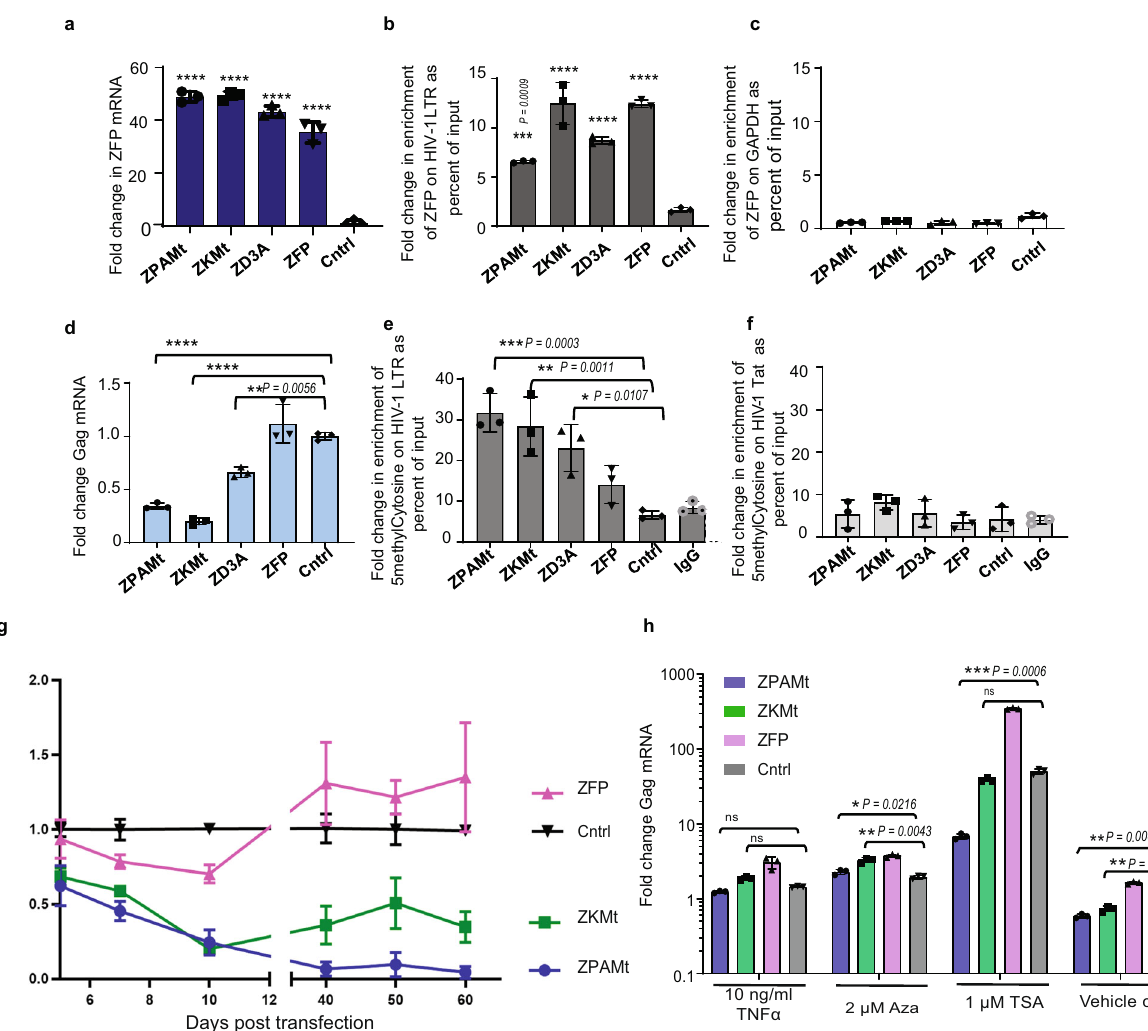
Fig. 2 ZPAMt and ZKMt occupy and methylate HIV-1 LTR promoter and repress virus expression long-term manner that is refractory to activation. a RT-qPCR for ZFP mRNA, two days post-transfection in CHI-Ju cells reveals overexpression of mRNA from ZFP362 fusion constructs or pcDNA control (cntrl). b , c ChIP with Myc tag beads reveals ( b ) occupancy of ZFP362 fusion proteins and ZFP362 alone on HIV-1 LTR and ( c ) little to no binding to the non-speci fi c GAPDH region. d RT-qPCR for Gag mRNA, ten days post-transfection of constructs in CHI-Ju cells reveals potent HIV-1 transcription repression from ZFP362 fusion constructs compared to ZFP362 backbone. e , f MeDIP assay from cells transfected with fusion constructs show ( e ) enhancement of CpG methylation on LTR ( f ) no signi fi cant changes in CpG methylation on Tat region of NL4-3 genome. For a – f the data represents means ± SD of triplicate treated samples and experiments were repeated twice. p -values were determined by one-way ANOVA followed by Tukey ’ s multiple comparisons post hoc test. **** p ≤ 0.0001. g Treated cultures were assessed by RT-qPCR for GagGag mRNA for two months post-transfection of ZPAMt and ZKMt. h RT-qPCR for Gag mRNA shows a level of reactivation of HIV-1 transcripts from transfected CHI-Ju cells after treatment with various latency reactivation reagents and 0.1% DMSO was used as vehicle control. Each experimental sample was compared to pcDNA transfected control. For g , h data represent mean ± SD of triplicate treated samples. For h p -values were determined by two-way ANOVA followed by Tukey ’ s multiple